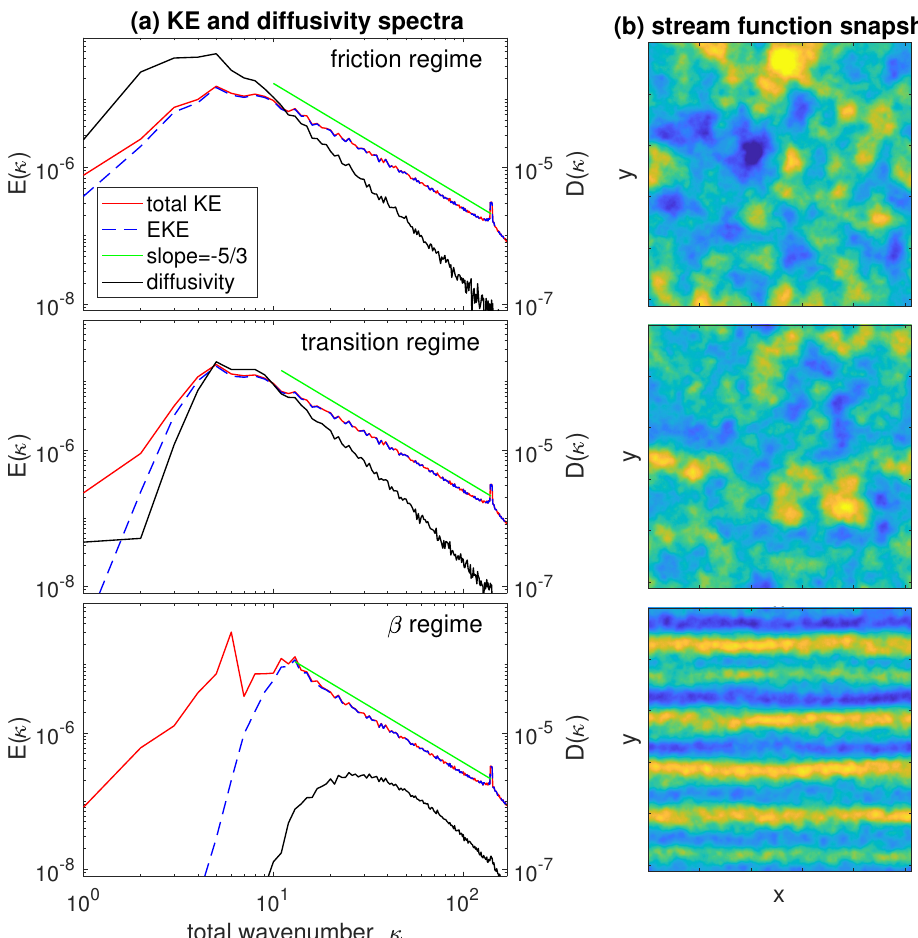
Figure 1. ( a ) total and eddy kinetic energy spectra and eddy diffusivity spectrum as functions of total wavenumber κ in three simulations, with the same (cid:101) and C D but varied β . ( b ) snapshots of stream function in the three corresponding simulations, where yellow and blue color denotes positive and negative values,